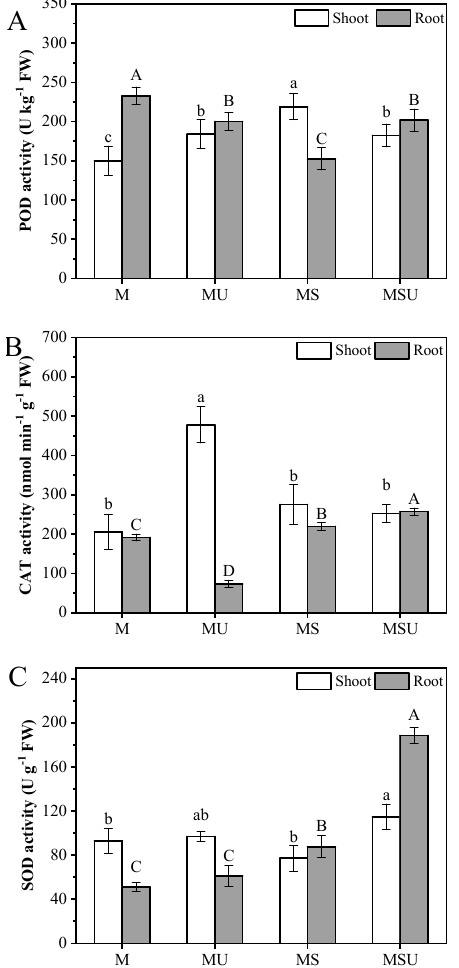
Figure 3. The antioxidant enzyme activities (SOD: superoxide dismutase ( C ); POD: peroxidase ( A ); CAT: catalase ( B )) in shoots and roots under the different rhizobium treatments. M: M. sativa , MU: M. sativa + urea, MS: M. sativa + S. meliloti , MSU: M. sativa + S. meliloti + urea. Bars are standard error ( n = 3). Different letters stand for significant difference ( p < 0.05) with Duncan’s post-test.